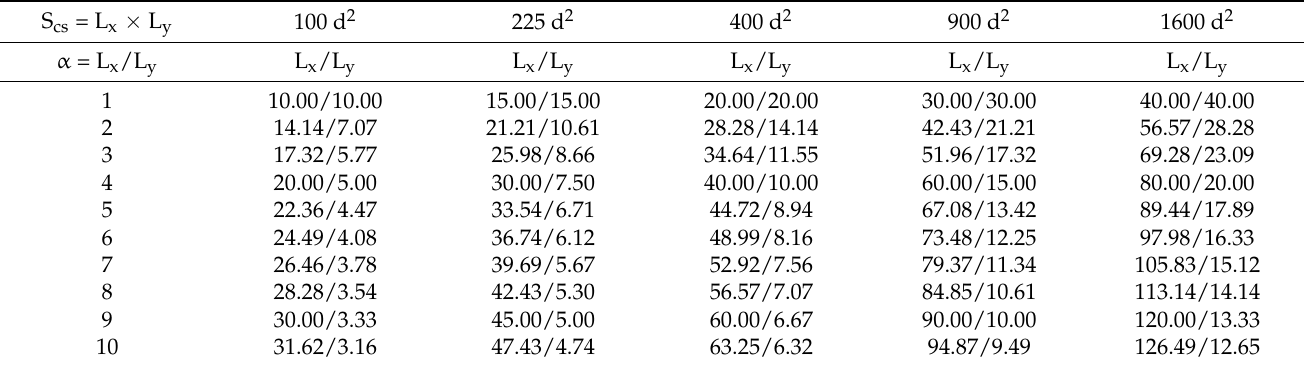
Table 2. Rectangular pebble-bed dimension used in the DEM